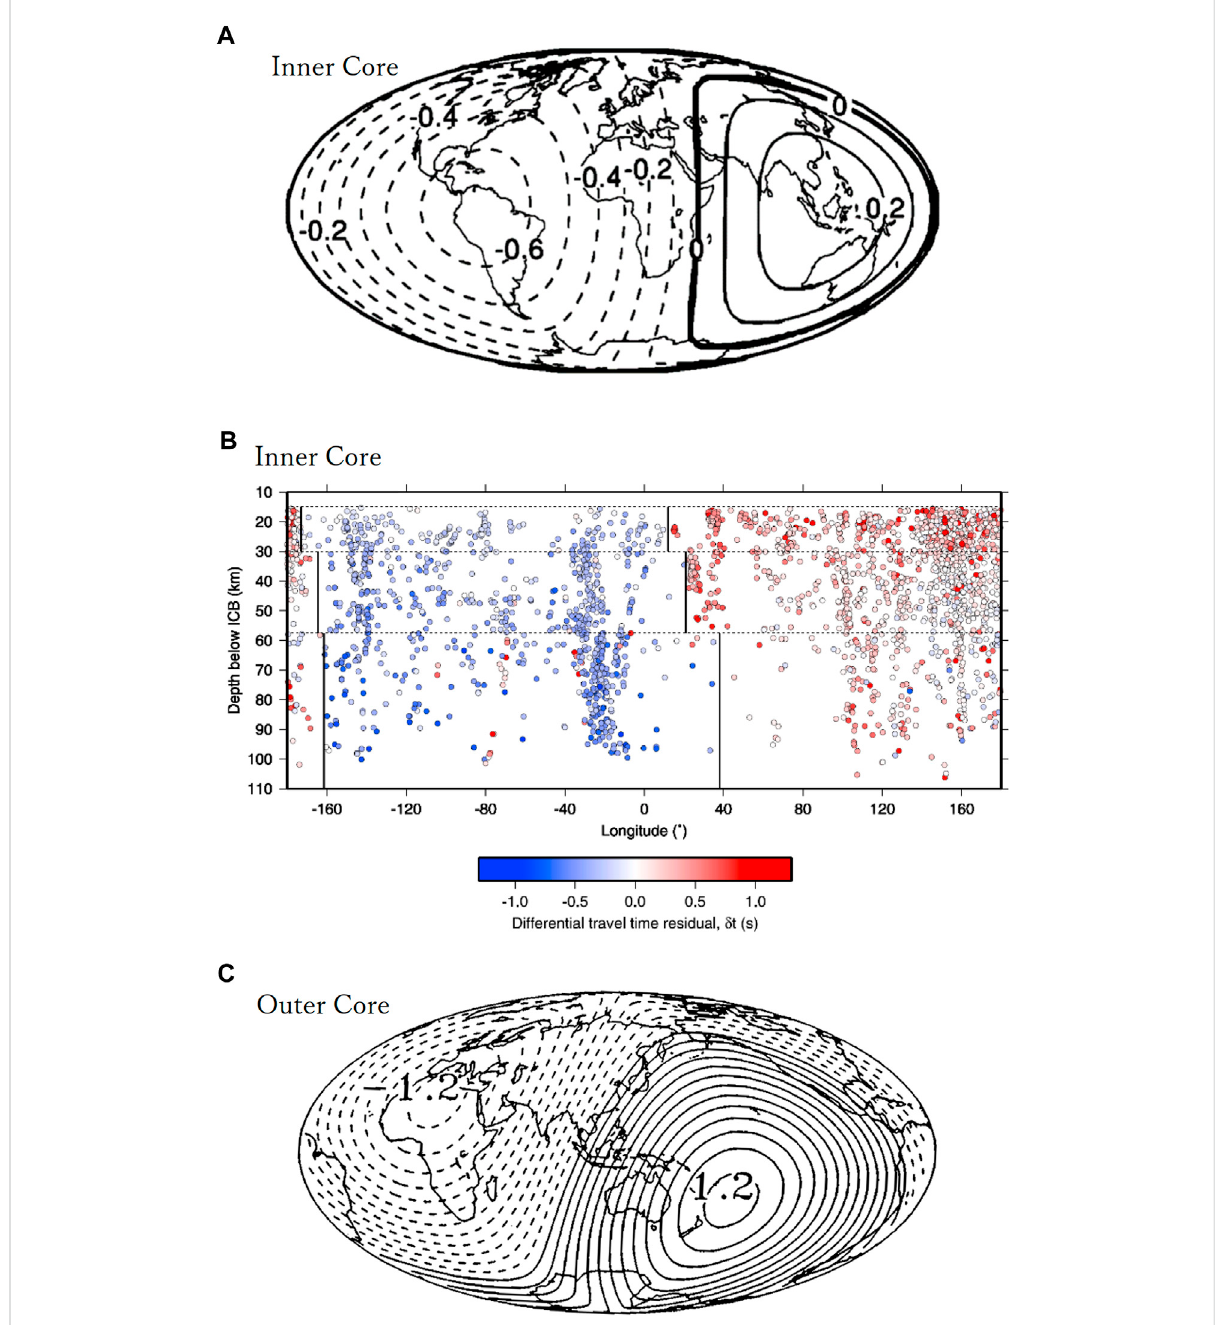
FIGURE 2 (A) Mapofthevelocity perturbationintheoutermost500 kmoftheinner core (Tanaka and Hamaguchi,1997).Solid anddashed linesrepresent positiveandnegativevalues,respectively.Thecontourintervalis0.1%. (B) PKIKP-PKiKPdifferentialtraveltimeresidualsasafunctionofPKIKPturning point longitude and depth below the inner core boundary (Waszek and Deuss, 2011). (C) The geographical distribution of degree-1 residual (in second) of differential travel times of SKKS-SKS and SKKKS-SKKS for the uppermost outer core (Tanaka and Hamaguchi,